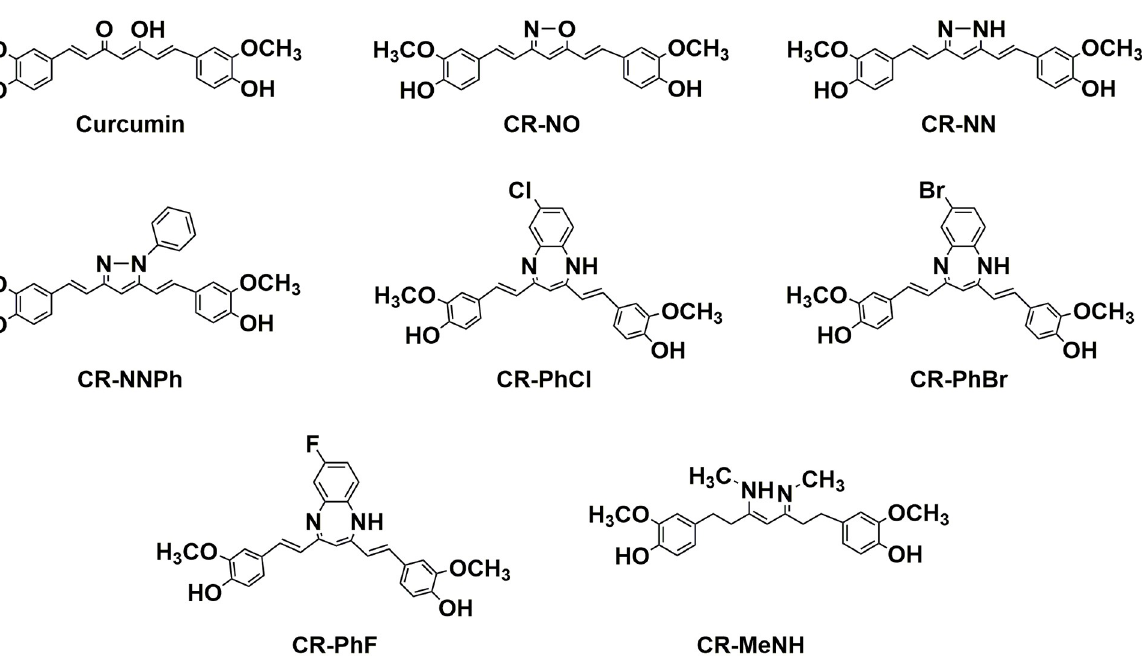
Fig 1. The chemical structures of the synthesized curcumin